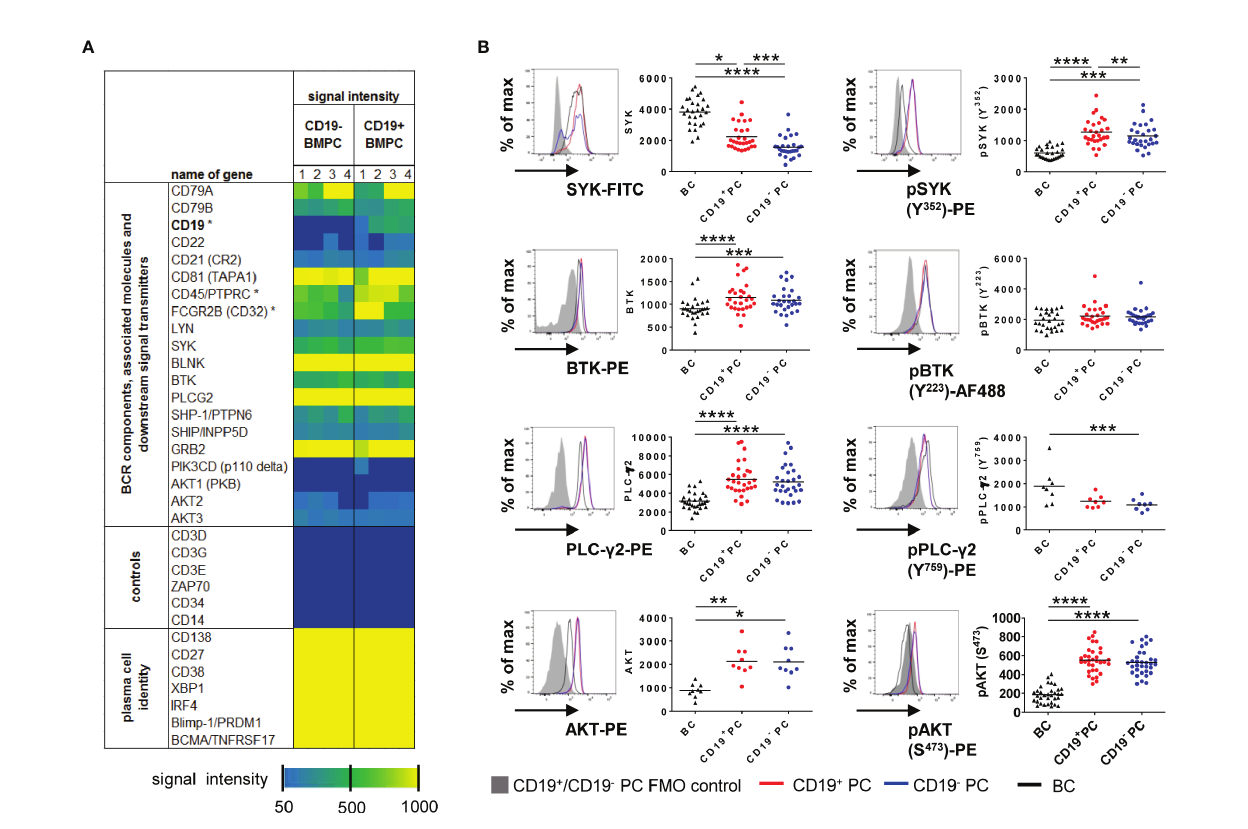
FIGURE 1 | CD19 + and CD19 − BMPC express BCR-associated kinases. (A) Gene expression pro fi ling of CD19 + and CD19 − BMPC. Expression of BCR components and molecules involved in intracellular BCR signaling in CD19 + and CD19 − BMPC. Dark blue indicates absent calls. Asterisks indicate signi fi cantly different expression (Fold change CD19 − vs CD19 + for CD19: − 11, 87; CD45: − 1, 67; CD32: − 1, 46). (B) Median fl uorescence intensities of the kinases SYK, BTK, PLC g 2 and AKT and their baseline phosphorylation among CD19 + , CD19 − BMPC and CD27 + CD38 − BMBC. Representative histogram of CD19 + (red lines) and CD19 − (blue lines) BMPC as well as CD27 + CD38 − BMBC staining (black lines) together with a FMO control ( fi lled grey histogram). Bar represents mean, **** p < 0.0001, *** p < 0.001, **p < 0.01, *p < 0.05 by Friedman-Test with Dunn ’ s correction for multiple comparisons. SYK/pSYK (Y 352 ): n = 28; PLC- g 2: n = 29, pPLC- g 2 (Y 759 ): n = 8, BTK/pBTK (Y 223 ): n = 28, AKT: n = 9, pAKT (S 473 ): n =